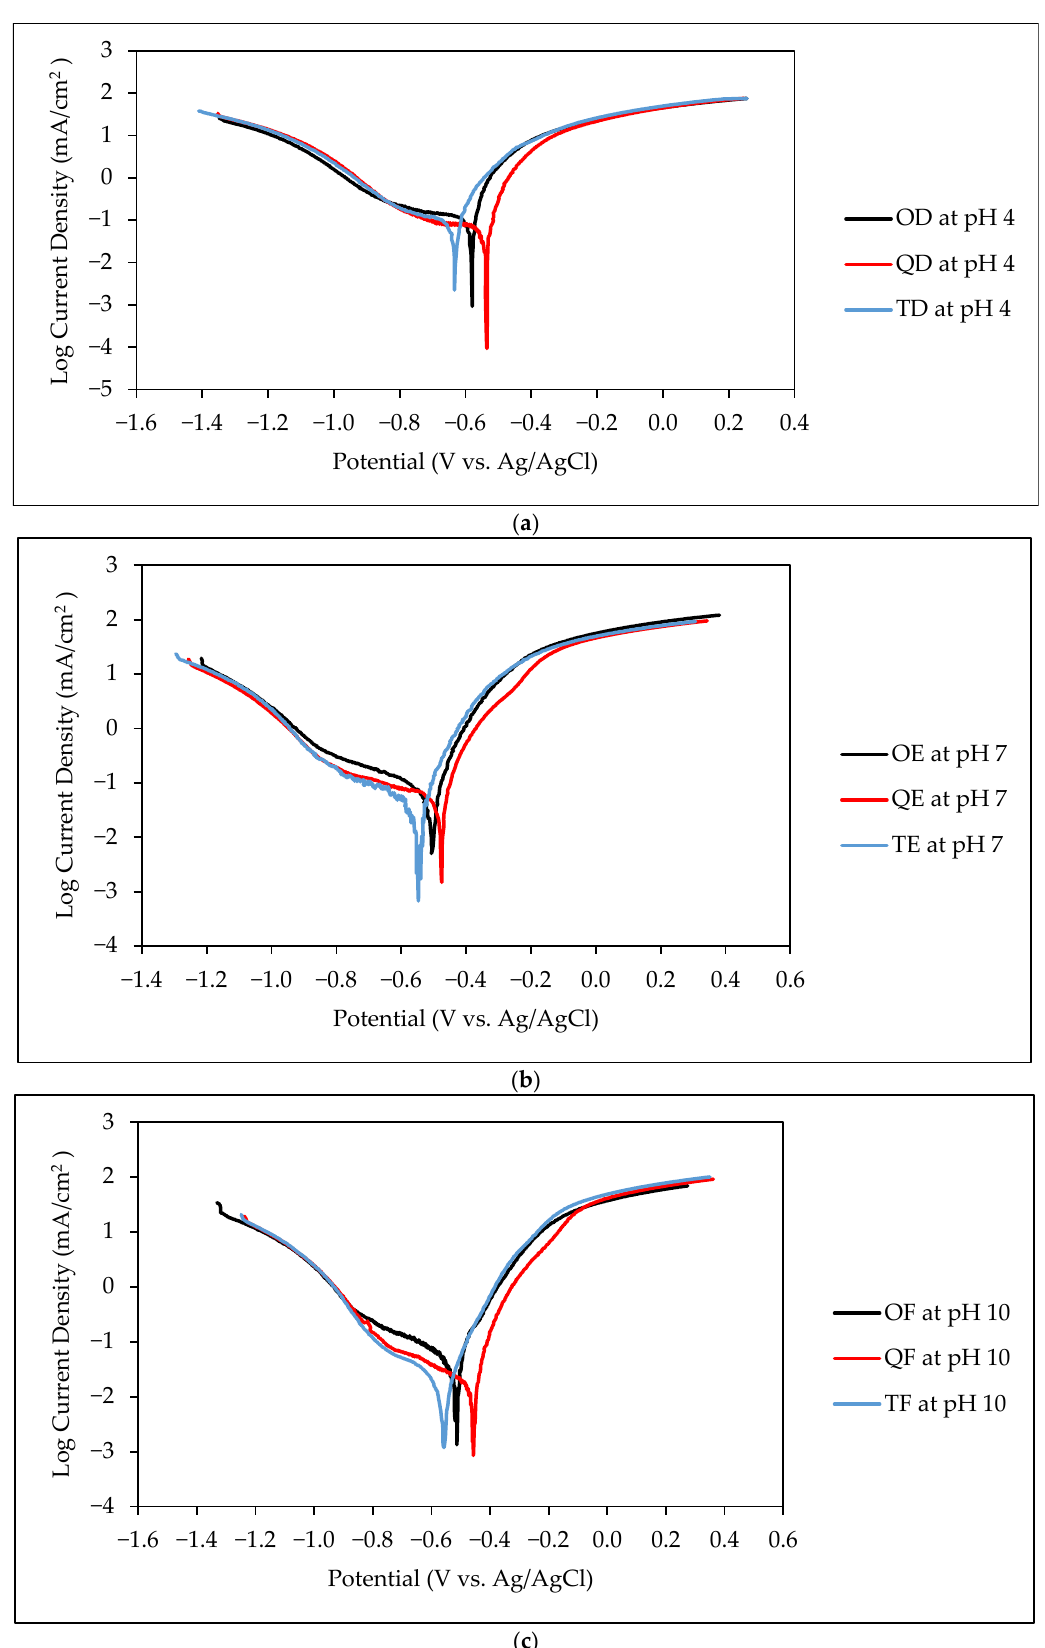
Figure 8. TAFEL curve of O, Q, and T samples at ( a ) pH 4, ( b ) pH 7, and ( c ) pH 10 in Cl − free